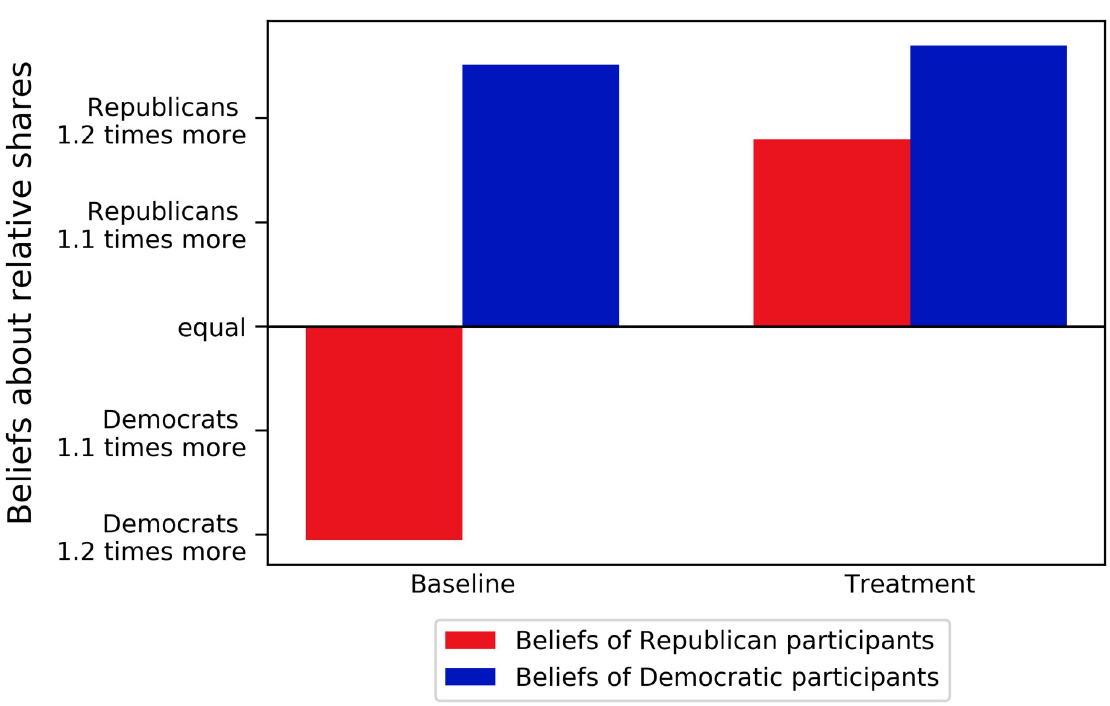
Fig 2. Beliefs about social media engagement in the 2018 midterm elections. Participants’ beliefs about the ratio of interactions in the run-up to the 2018 Midterm election. This was measured on a scale that ran from “Democrats three times more than Republicans” to “Republicans three times more than Democrats” with “Equal” as the